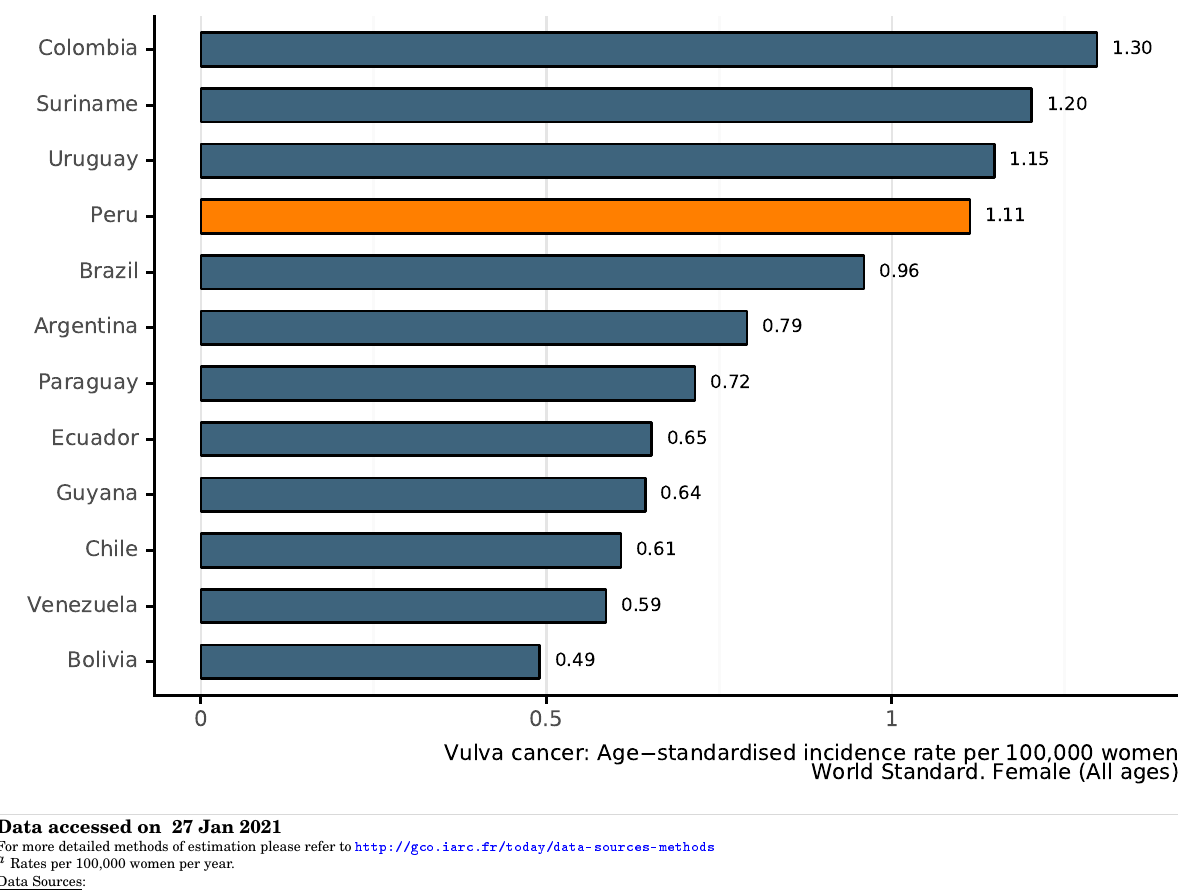
ages)BoliviaVenezuelaChileGuyanaEcuadorParaguayArgentinaBrazilPeruUruguaySurinameColombia 0 0.5 1 Vulva cancer: Age standardised incidence rate per 100,000 women World Standard. Female (All